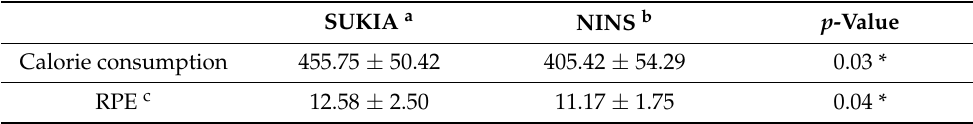
Table 3. Calorie consumption and RPE between SUKIA and NINS.